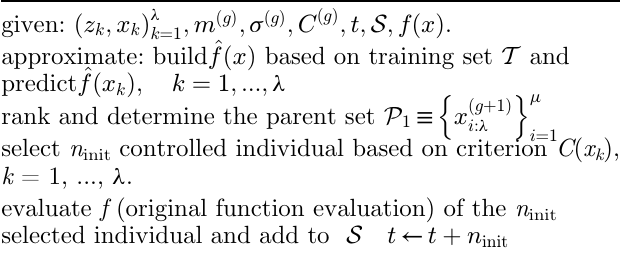
Algorithm 1. Approximate Ranking Procedure